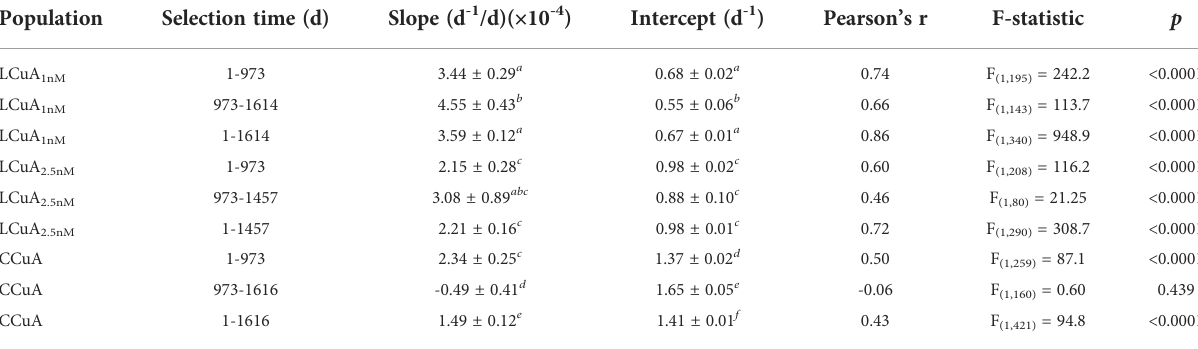
TABLE 2 Linear regression statistics of growth rate (d -1 ) of the low Cu-adapted (LCuA 1nM , LCuA 2.5nM ) and control (CCuA) populations as a function of selection time for the entire selection